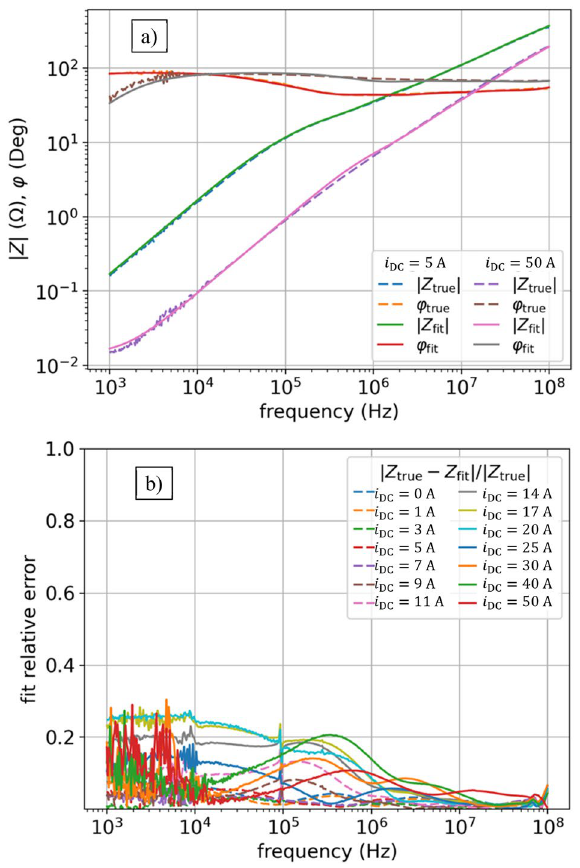
Figure 8. DE results of impedance Z ( f , i DC ) fitting for model (6): ( a ) fit vs true values of | Z | (cid:31) f , i DC (cid:30) and ϕ( f , i DC ) for two currents: i DC = 5 A, i DC = 50 A; ( b ) relative error as per (4) for all currents. Now using